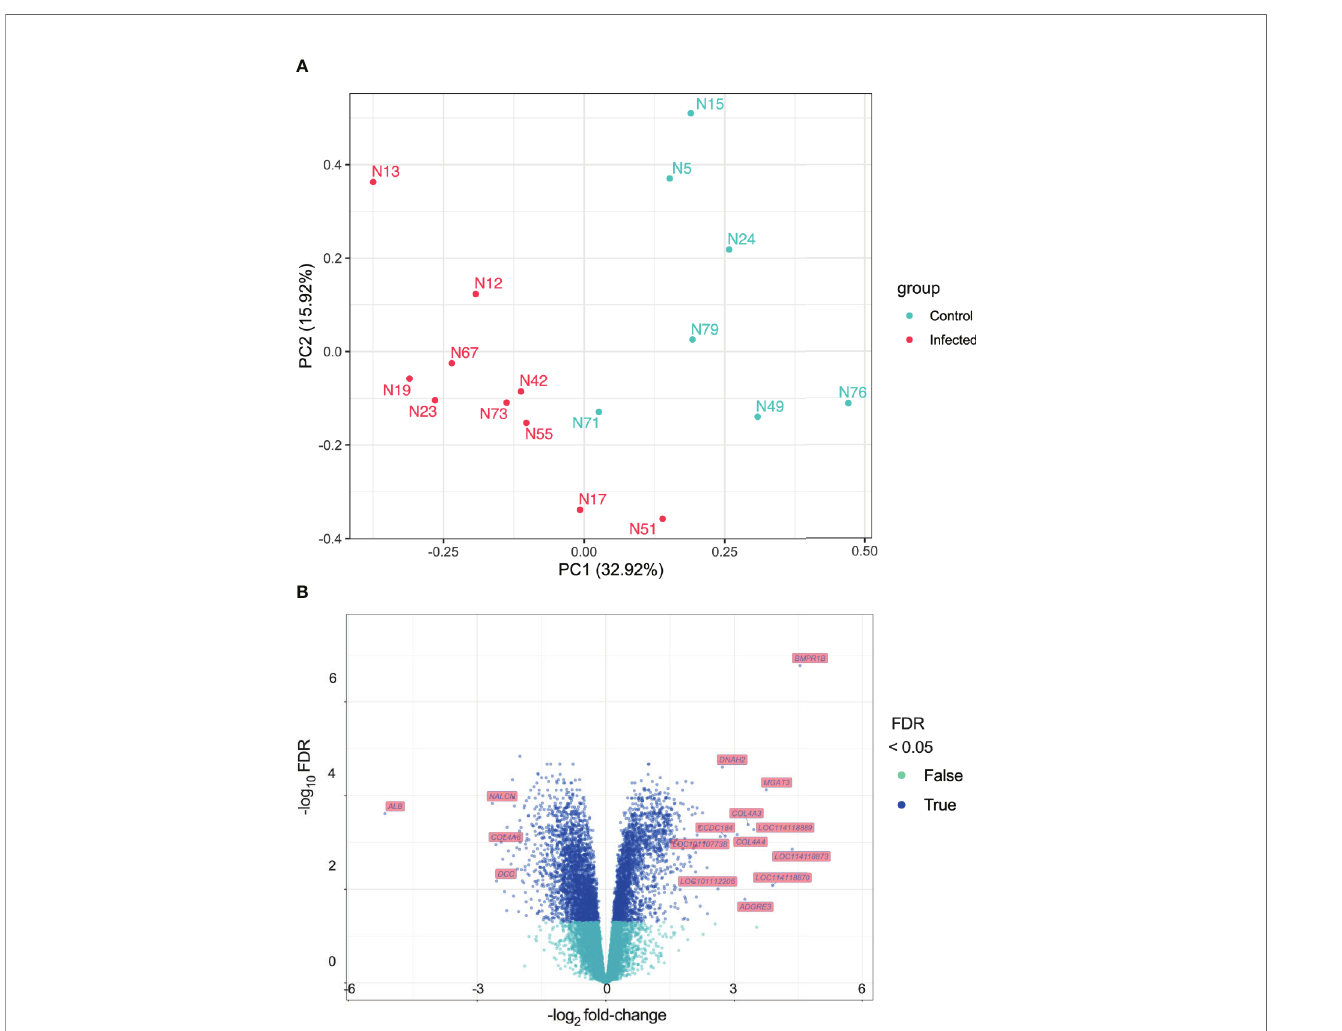
FIGURE 2 | Differential Expression analysis (A) Principal Component Analysis (PCA). Principal components were calculated and the fi rst two ranked by proportion of variation explained are shown (PC1 and PC2). (B) Volcano plot showing log 2 fold-change (x-axis) and their − log 10 FDR values (y-axis) for the DEGs